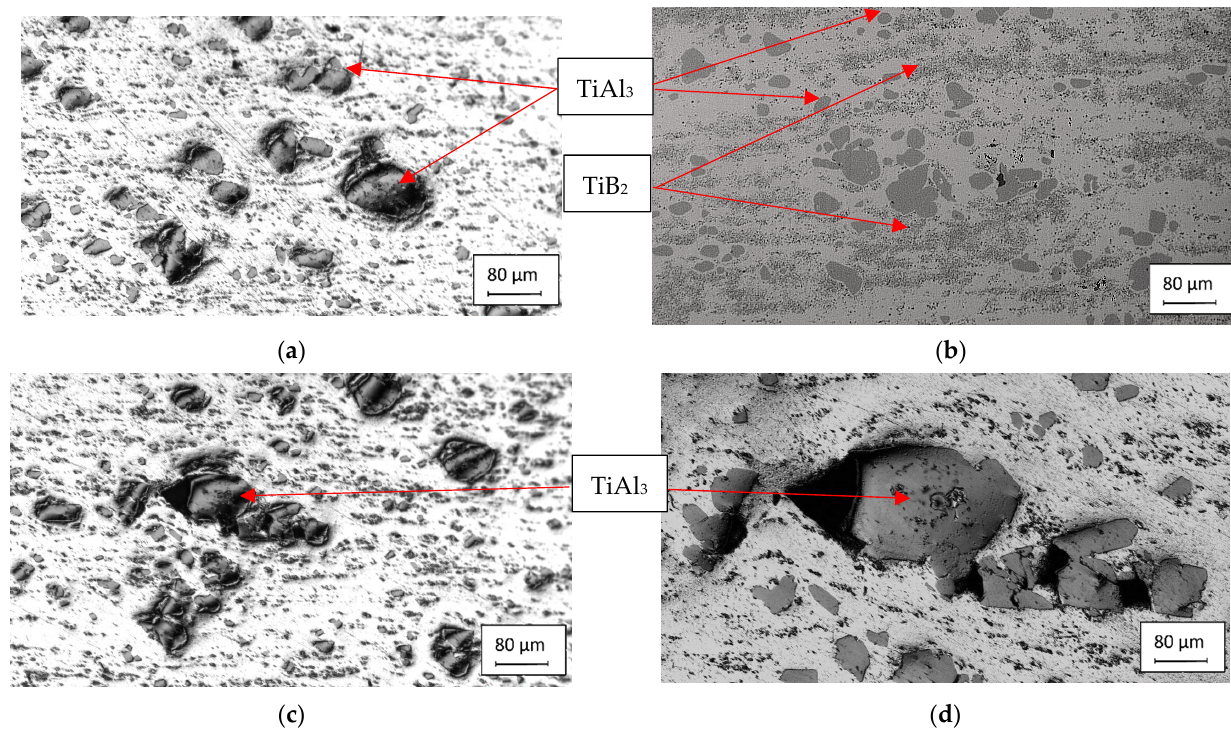
Figure 16. Unsatisfactory microstructure of AlTi5B1 inoculation wires: ( a ) coarse intermetallic phases; ( b ) large compact clusters of intermetallic phases; ( c ) agglomerating intermetallic phases; ( d ) intermetallic phases disintegrated by forming.